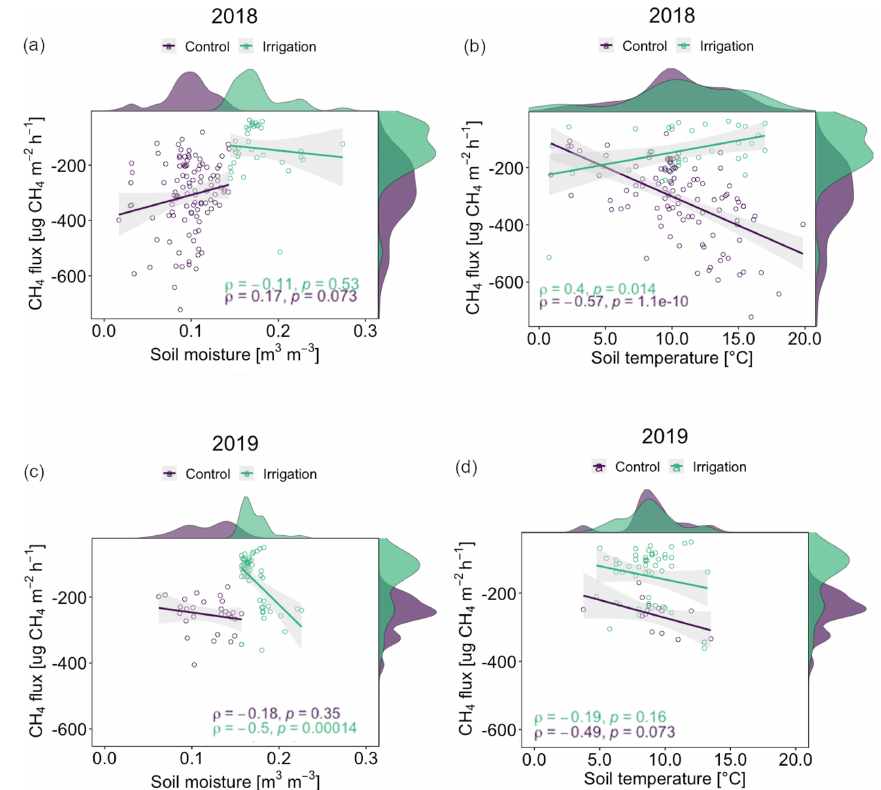
Figure 8. Correlations (Pearson’s coefficient, ρ ) between soil moisture and CH 4 flux (a, c) and soil temperature and CH 4 flux (b, d) with smoothed frequency histograms in 2018 and 2019. The emission case of 27 June 2019 was removed from the data in the correlation analyses for more clear presentation.